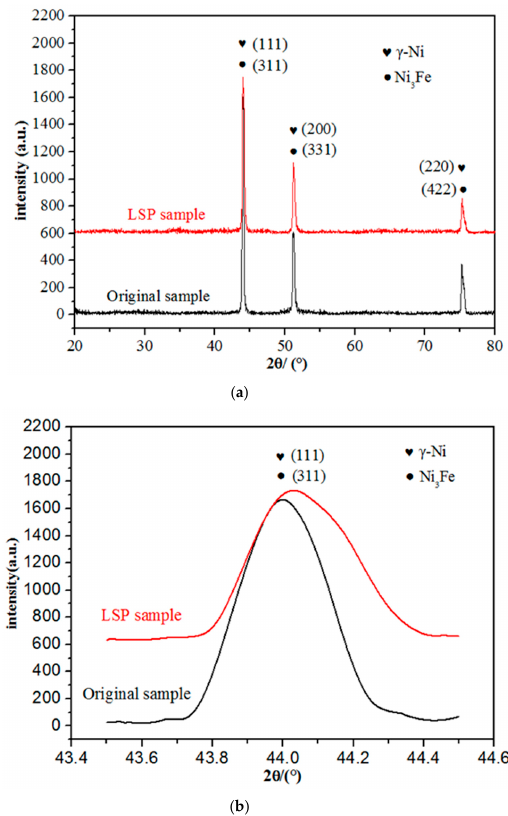
Figure 3. ( a ) XRD patterns of GH3039 with and without LSP treatment; and ( b ) Local magnified graph in the 43.5°–44.5° range of GH3039 XRD patterns with and without LSP treatment.